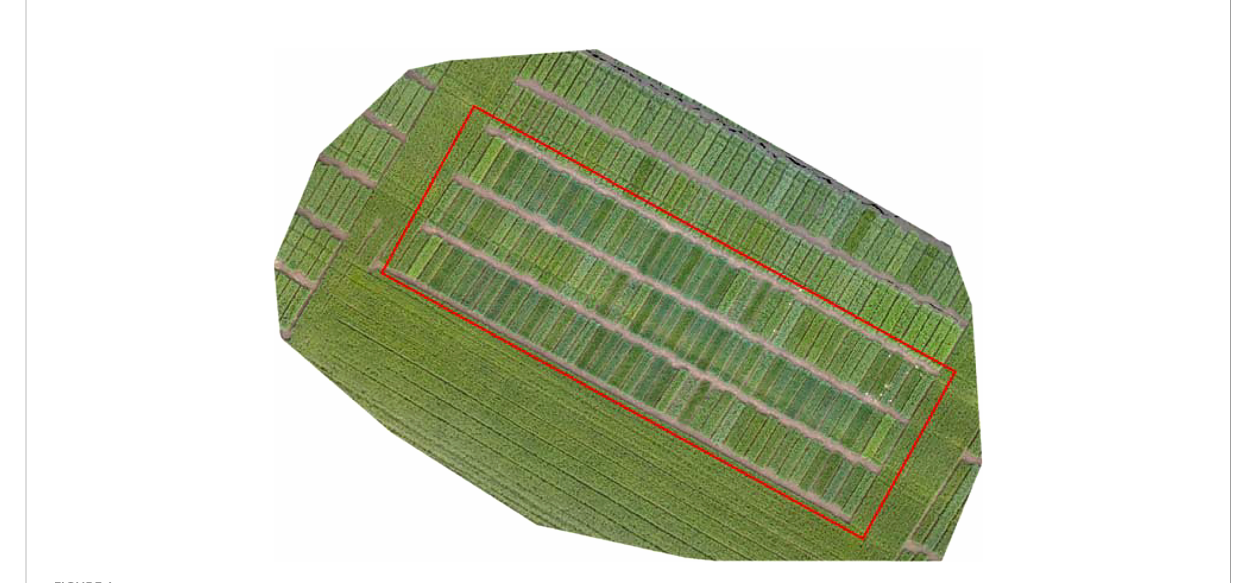
FIGURE 1 Aerial view of the experimental plots in May